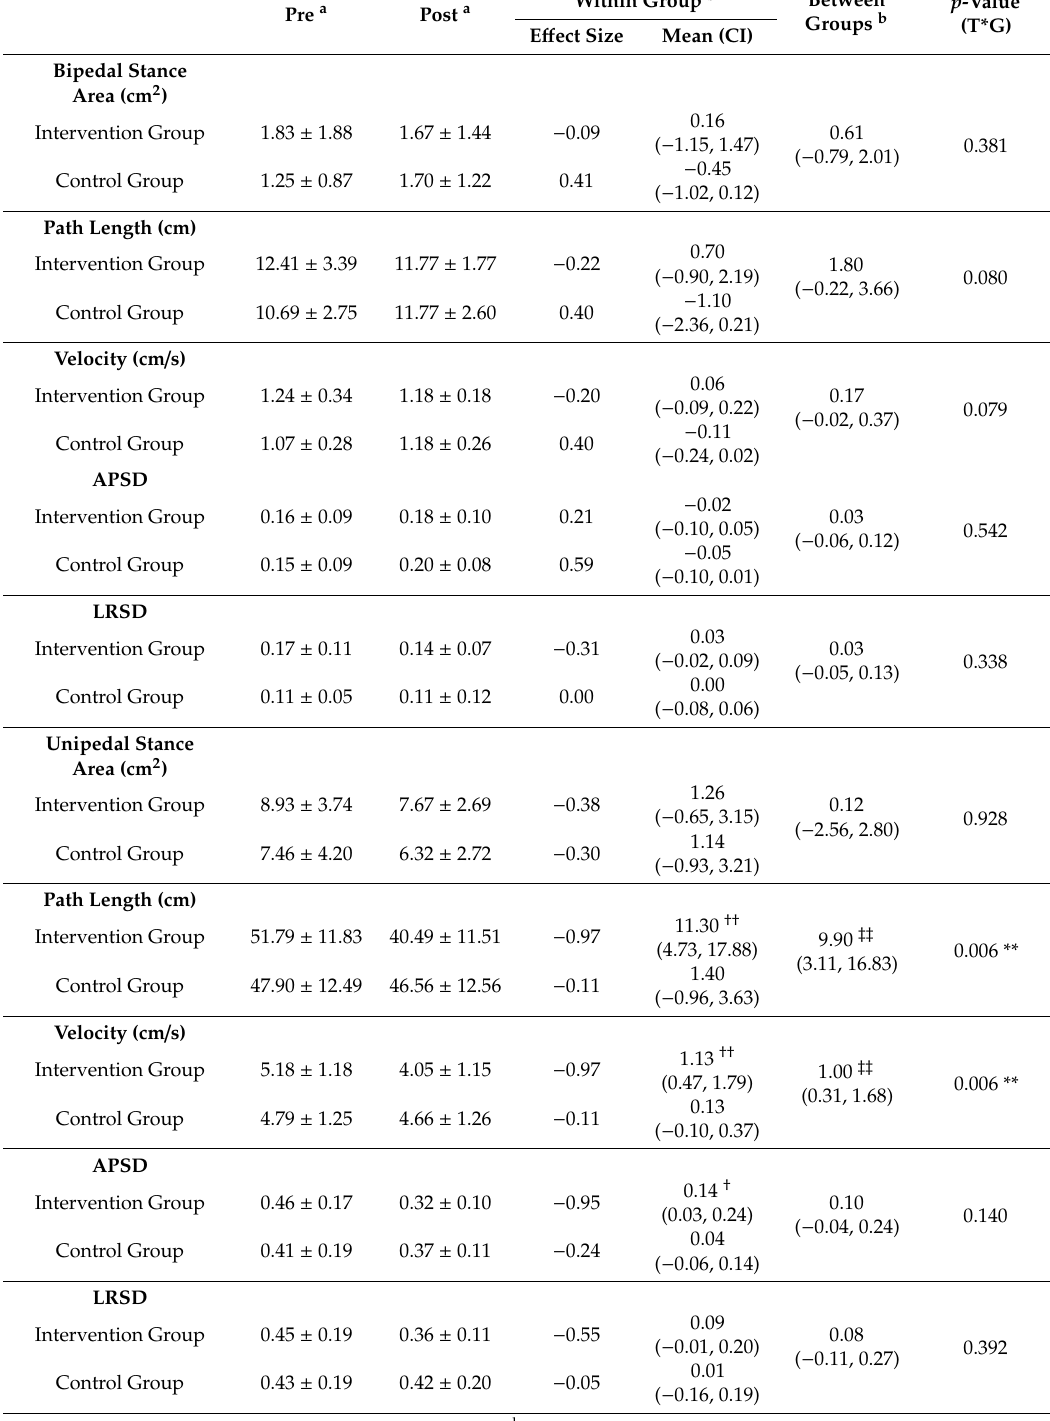
Table 5. The changes in balance